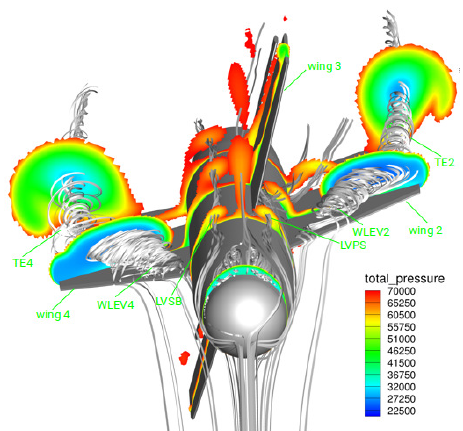
= 5 × 10 5 , σ = 17.5°, λ = 45°), (Adapted with Ref